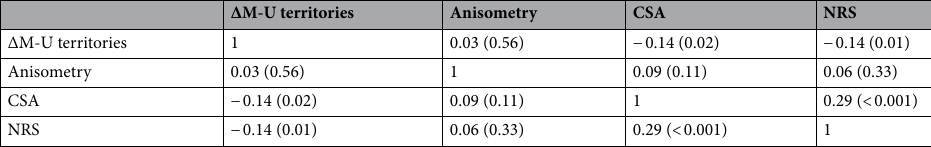
Table 5. Correlation coefficients ( P values) between the examined parameters and pain score. ΔM-U territories temperature difference between the median and ulnar nerve digits, Anisometry median nerve- innervated digits anisometry, CSA cross-sectional area of the median nerve, NRS numerical rating scale of